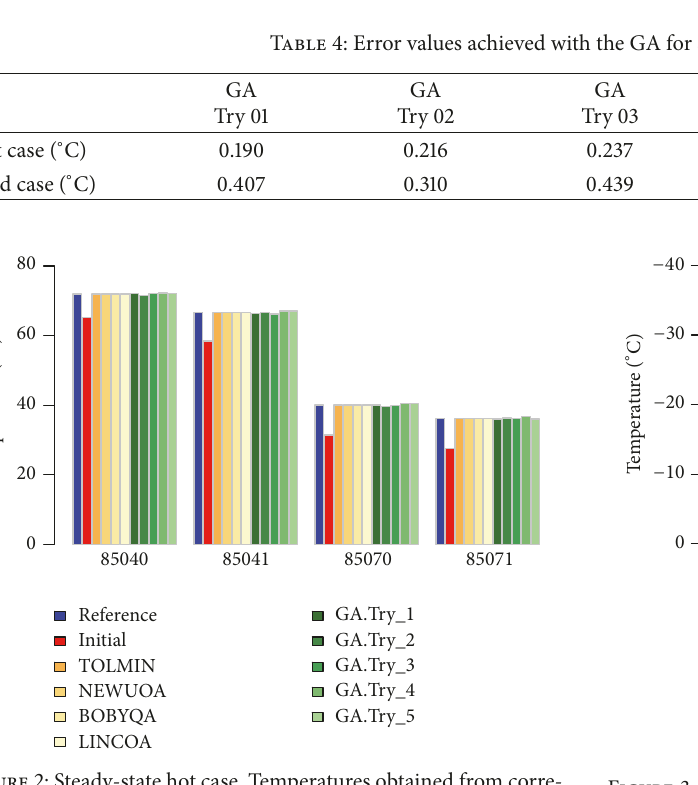
Figure 3: Steady-state cold case. Temperatures obtained from cor-